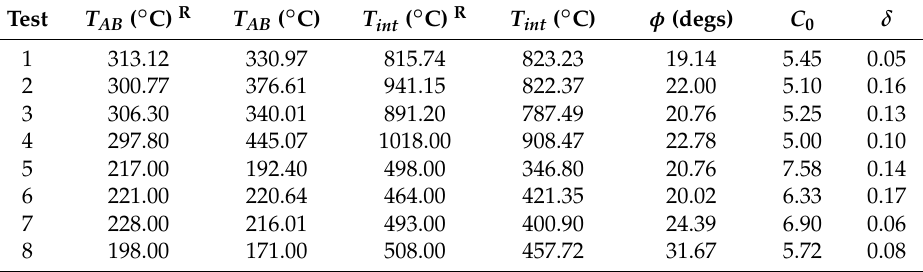
Table 3. Predicted temperature distribution, and other process